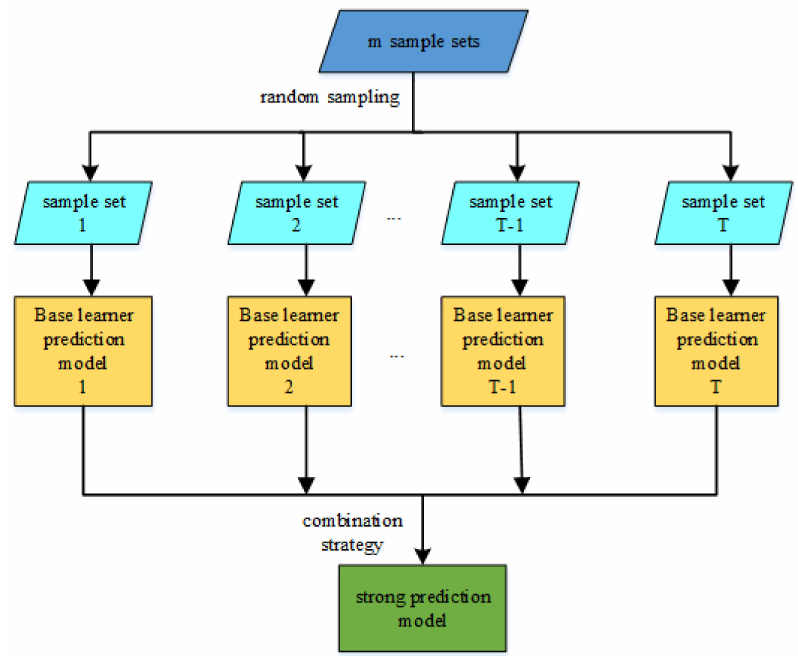
Figure 2. Parallel ensemble learning based on Bagging.